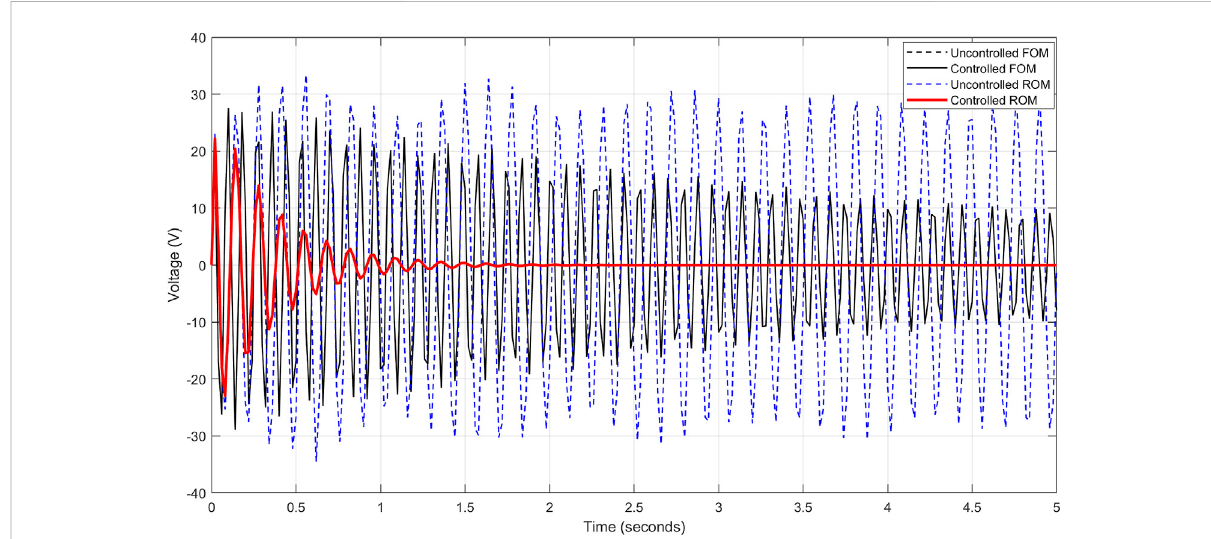
Response of the full model without control considering the selections 46 and 112 degrees of